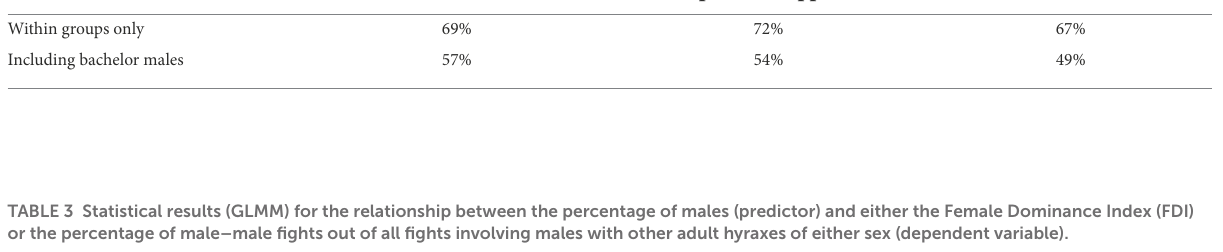
TABLE 2 Partial female dominance over males according to three different measurements for interactions between adult group members only and group members with bachelor males. Measure of female dominance Female Dominance Index (FDI) Average percentage of intersexual fights won by